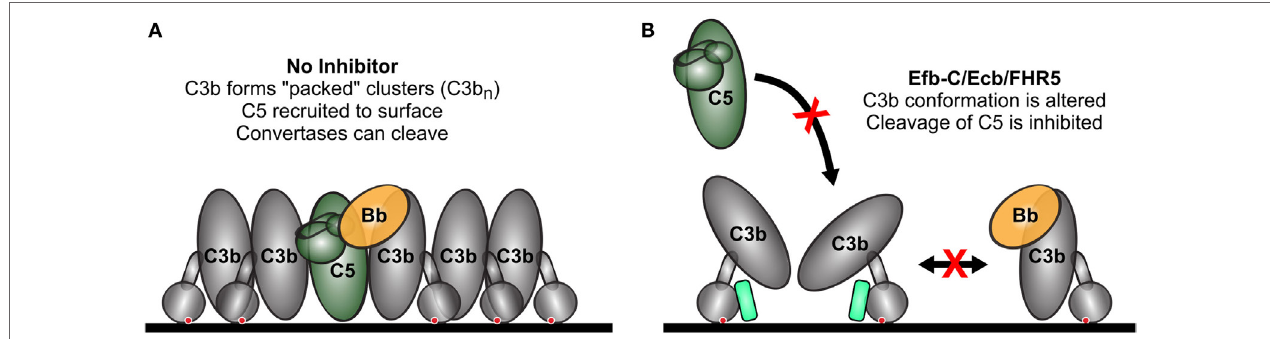
FigUre 6 | Model for selective inhibition of C5 conversion. (a) Under normal conditions, high levels of accessory C3b (C3b n ) deposition on a cell surface around existing C3 convertases enables binding and conversion of C5. All C3b molecules are tightly packed and aligned in the same vertical orientation, both of which are necessary for efficient C5 conversion. (B) Thioester domain (TED)-binding molecules (i.e., Efb-C and Ecb) act as a wedge to separate TED from the rest of C3b, which alters its surface conformation and prevents efficient C5 conversion. Colors of molecules correspond to Figures 1c,D and 3a , with Efb-C/Ecb shown in spring green. The red crosses indicate inhibition of C5 and C3bBb binding to surface-bound accessory C3b molecules (C3b n